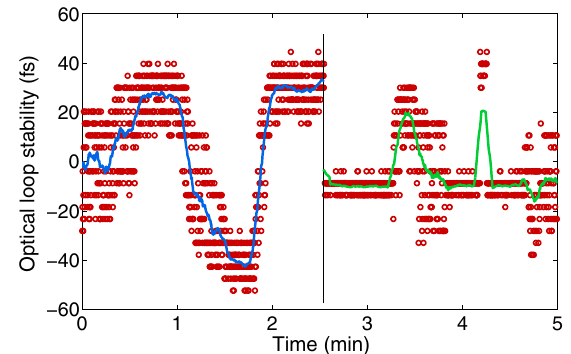
FIG. 39. Test of the stability of the optical phase detector by addition of a manually varied voltage offset to the error signal [109]. The initial curve shows stable operation following the induced changes, until the loop breaks after 2.5 minutes (in- dicated by the vertical line). The optical lock is recovered once the perturbation is removed and the optical gains are readjusted (curve to the right of the vertical line). The blue and green curves represent sliding averages over 20 consecutive measurements. The integrated timing jitter is 11 fs (rms) in the range between 1 Hz and 100 kHz. (As in Fig. 38, the resolution of the sampling clock leads to a clustering of the stability values at distinct